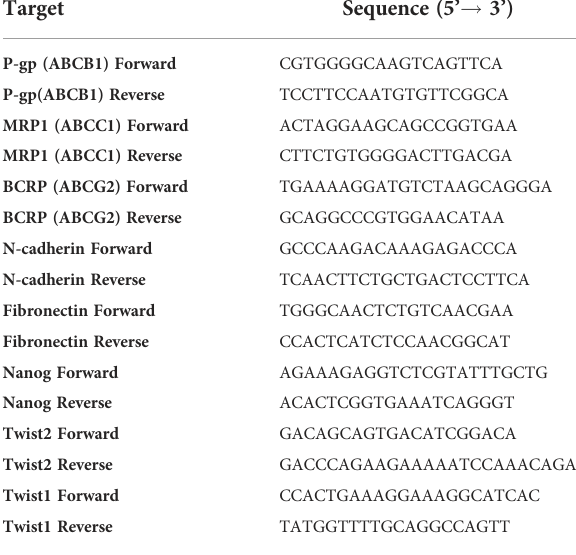
TABLE 3 qPCR primer